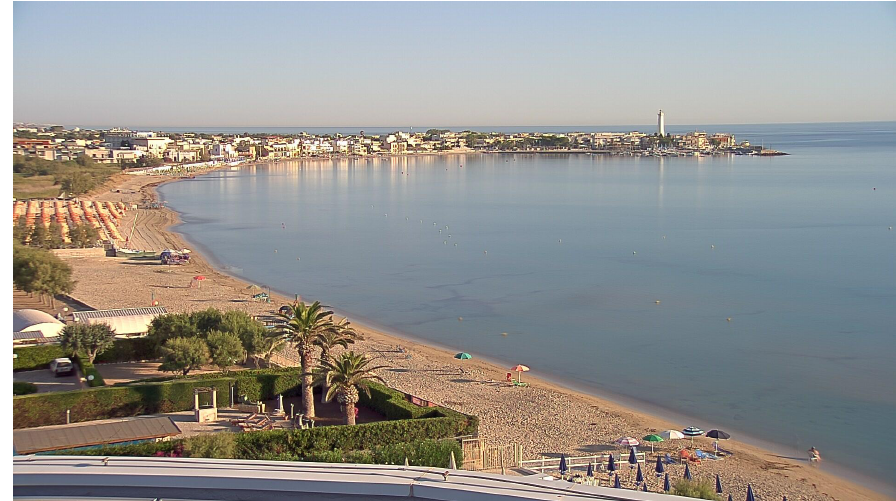
Figure 3. Example of the image acquired by IP camera placed on-site along Torre Canne beaches. The camera system is configured to acquire images with a sampling interval of 30